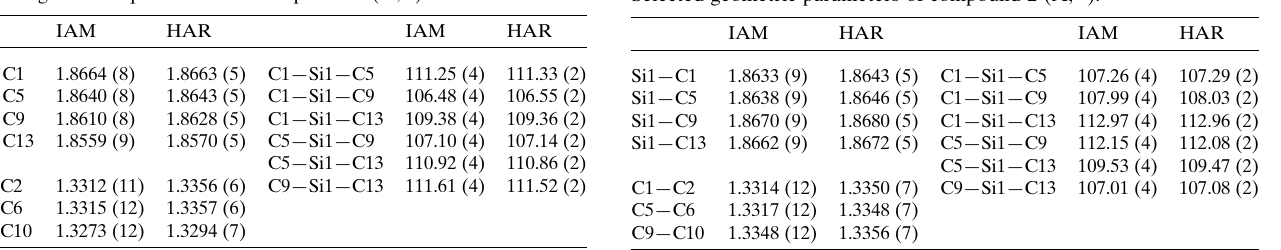
Table 1 Selected geometric parameters of compound 1 (A˚ , (cid:3) ).